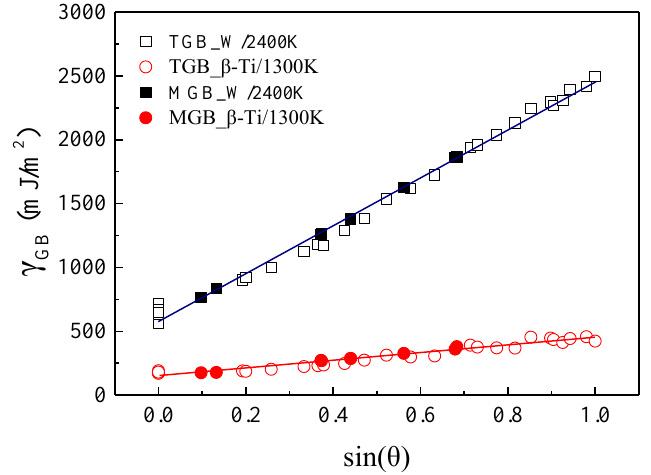
Figure 3. The GBEs of ∑3 GBs as a function of sin( θ ). The θ is the angle between the misorientation axis and the GB plane.